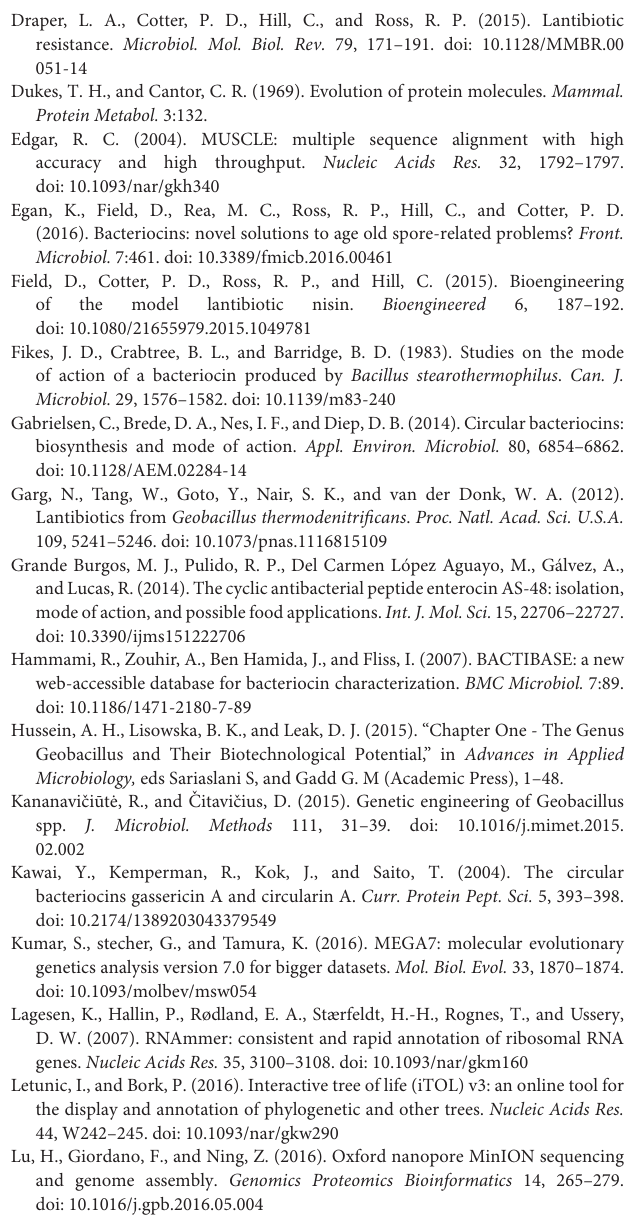
Figure S1 | Phylogenetic arrangement of predicted lantibiotics. Figure S2 | Phylogenetic arrangement of predicted sactibiotics. Figure S3 | Phylogenetic arrangement of predicted LAPs. Figure S4 | Phylogenetic arrangment of predicted circular bacteriocins. Figure S5 | Phylogenetic arrangement of predicted class II